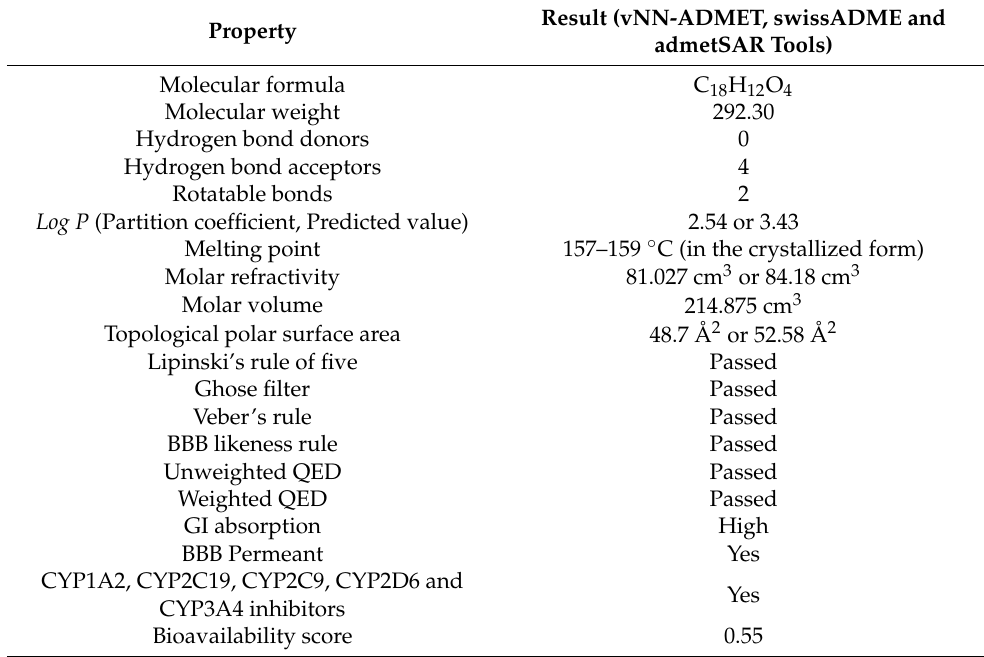
Table 1. Physicochemical and drug-likeness properties of